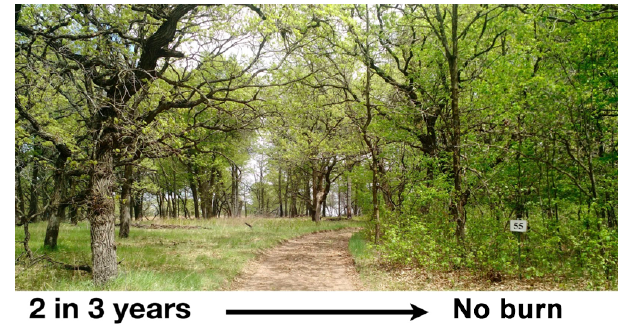
Figure 3. The Cedar Creek Ecosystem Science Reserve burn ex- periment. The difference in vegetation between unburned and fre- quently burned treatment stands is clearly shown. On the left, a fre- quently burned stand is characterized by increased canopy open- ness and higher grass dominance. On the right, an unburned control stand is characterized by dense undergrowth and high oak domi- nance. Photo credit: Peter